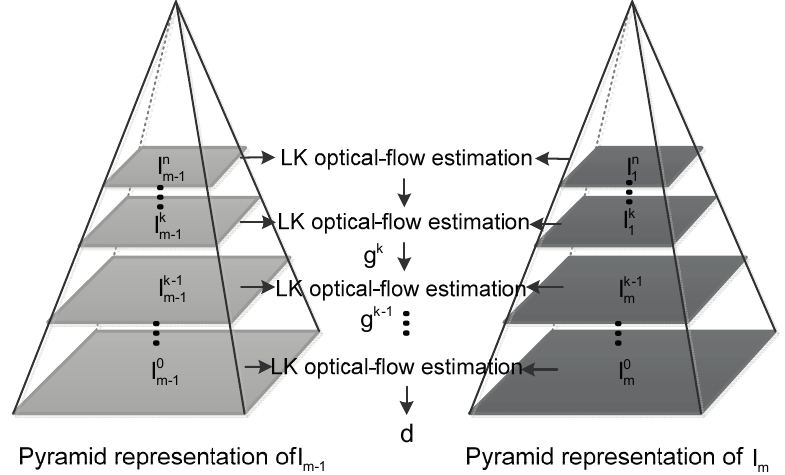
Figure 3. Pyramid implementation of the optical-flow tracking operation. LK optical-flow: Lucas–Kanade optical-flow algorithm.